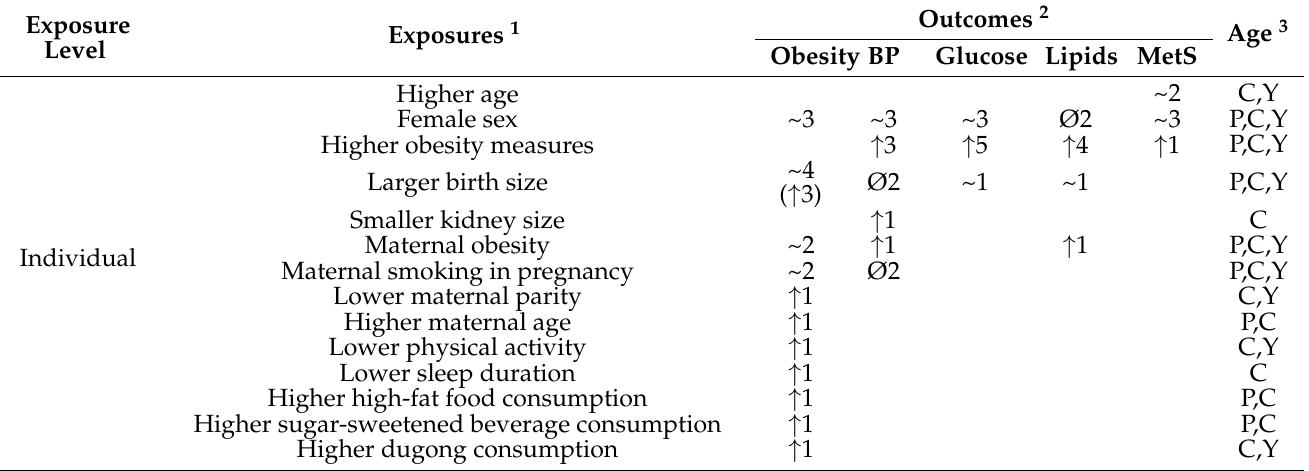
Table 2. Summary of exposures associated with cardio-metabolic risk markers among Indigenous children and adolescents, with the number of studies and direction of the association